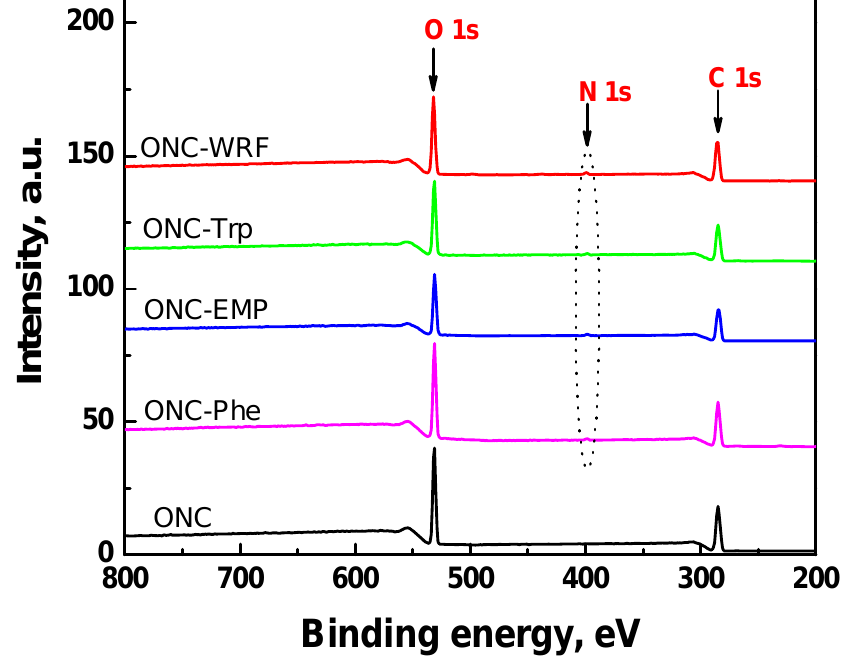
Figure 6. XPS survey spectra of ONC, ONC-Phe, ONC-EMP, ONC-Trp and